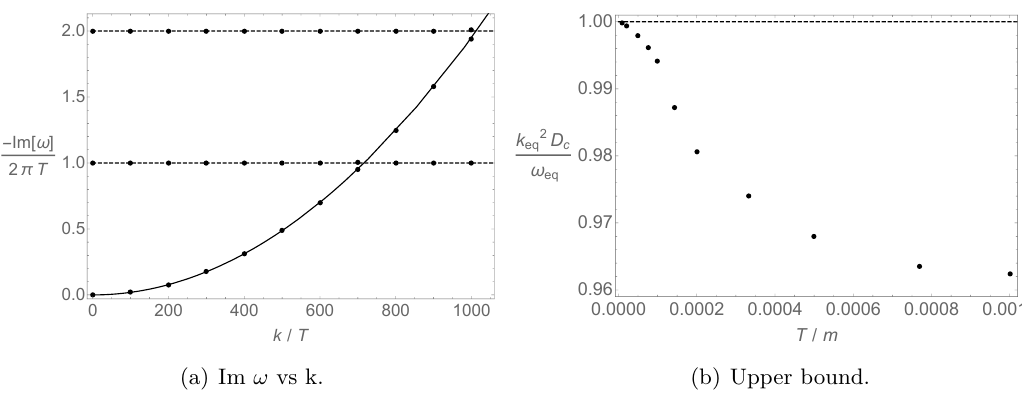
Figure 7 . Left: quasi-normal modes at J = 1 / 3 with m/T = 10 5 . The solid line is the hydro- dynamic mode (2.7). The dashed lines are IR modes (3.2). Right: the upper bound of the charge diffusion constant at J = 1 / 3 . The dashed line denotes the equality in (3.7).